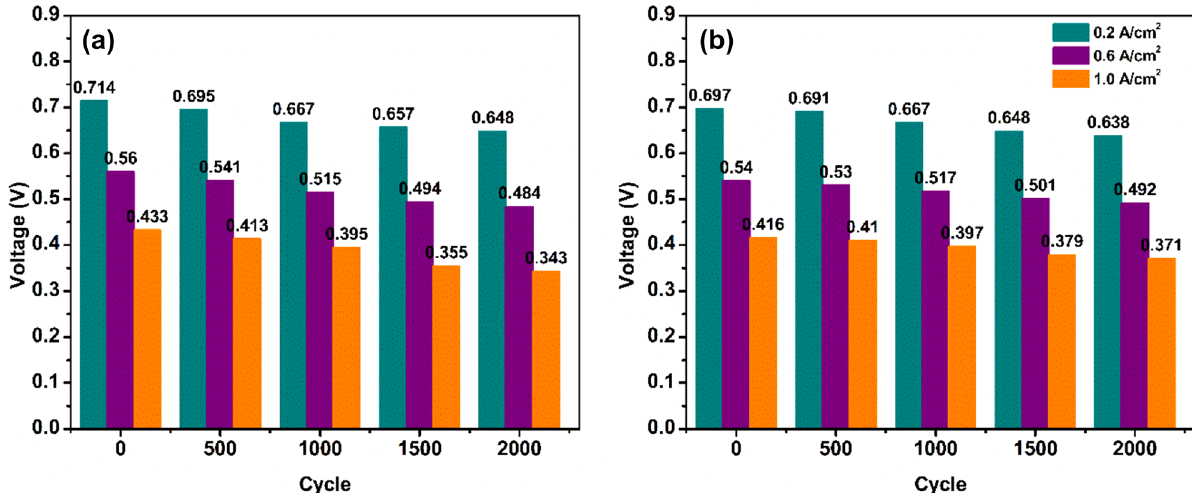
Figure 3. Voltage decay of ( a ) DLC1 and ( b ) DCL2 at 0.2, 0.6, and 1.0 A/cm 2 current